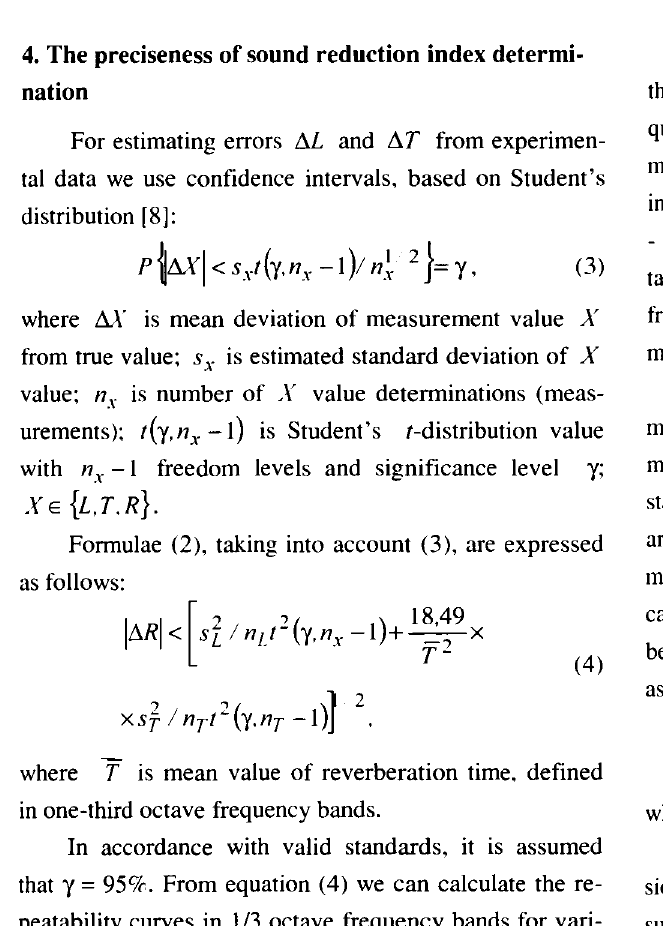
accuracy of sound reduction index determination from